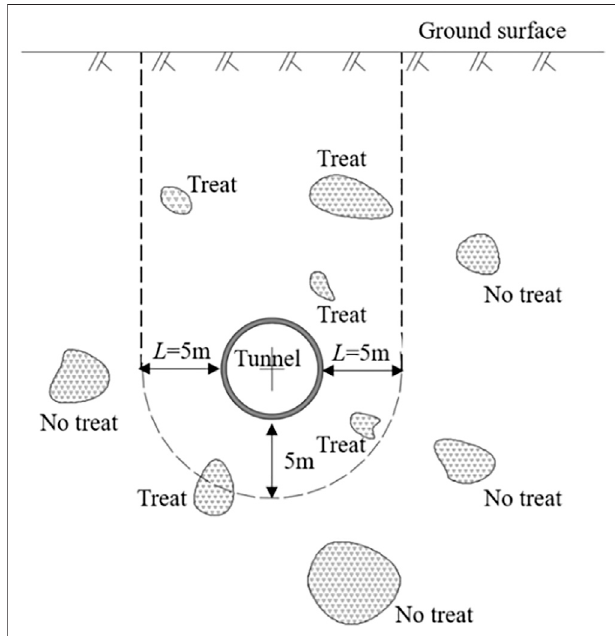
FIGURE 8 | The treatment criteria for karst caves around R3 metro Tunnel.